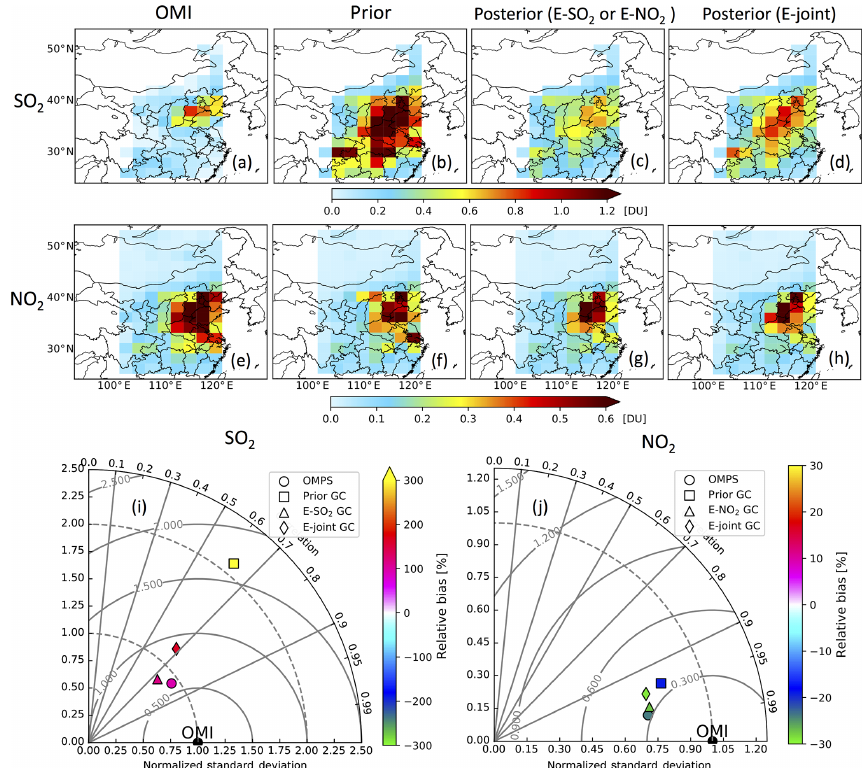
Figure 5. Comparisons of VCDs of SO 2 and NO 2 from the OMPS and the GEOS-Chem prior and posterior simulations with that from the OMI in October 2013 over China. The first row is SO 2 VCDs from the OMI (a) , the prior simulation (b) , the E − SO 2 posterior simulation (c) , and the E-joint posterior simulation (d) . The second row is NO 2 tropospheric VCDs from the OMI (e) , the prior simulation (f) , the E − NO 2 posterior simulation (g) , and the E-joint posterior simulation (h) . The third row is Taylor diagrams for comparing GEOS-Chem simulations (squares for prior, triangles for posterior E − SO 2 or E − NO 2 , and diamonds for E-joint) and OMPS observations (circles) with OMI SO 2 (i) and NO 2 (j)